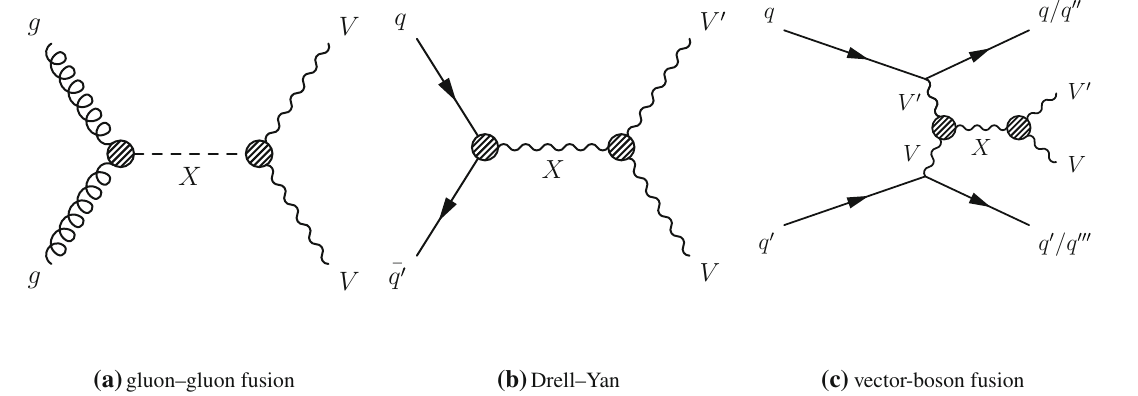
Fig. 1 Representative Feynman diagrams for the production of heavy resonances X with their decays into a pair of vector bosons. The hashed circles represent direct or effective couplings